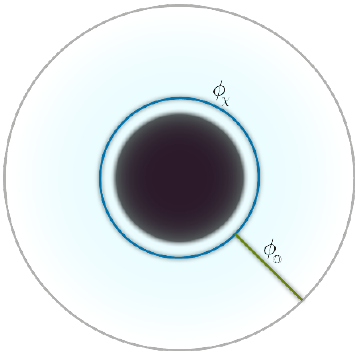
Figure 1 . Con(cid:12)guration of geodesics for the holographic calculation of the average three point coe(cid:14)cient in the constant time slice of the charged BTZ